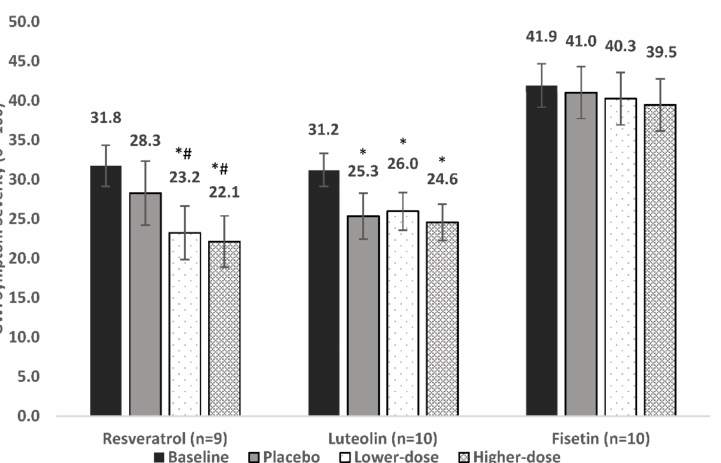
Figure 3. Main treatment effects of resveratrol, luteolin, and fisetin on Gulf War Illness (GWI) symptom severity. Average symptom levels (0–100) are presented for the baseline, placebo, lower- dose, and higher-dose conditions. * Significantly lower than baseline ( p < 0.05); * # significantly lower than baseline and placebo ( p <